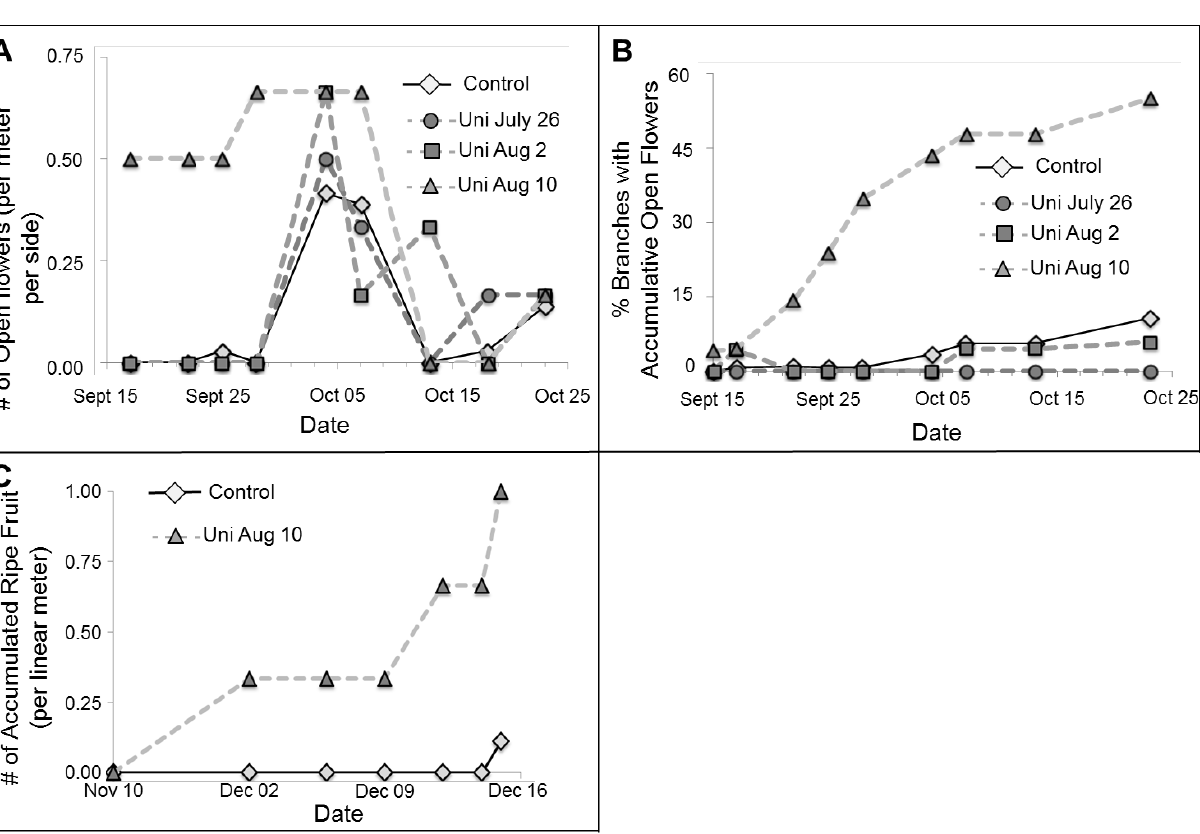
Figure 4. Uni spray on PD vines in an experimental field (2010). Treatments: 200 ppm Uni sprayed on July 26/August 2/August 10 and control (not treated). We visited the plot seven times in a period of 22 days starting September 15. ( A ) The number of open flowers per running meter of trellis per side on that certain day; ( B ) For each treatment, we gathered information on 20 random shoots (10 per side, west or east) that were appointed and marked before treatments began. The accumulative percentage of blooming branches is presented; ( C ) Accumulated ripe fruit number per linear meter of trellised vines. Fruit was defined as ripe upon abscission. We collected and counted the number of fruit on the ground on each